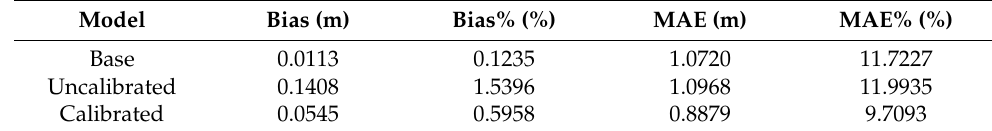
Table 4. Prediction accuracy of HCB with different models.